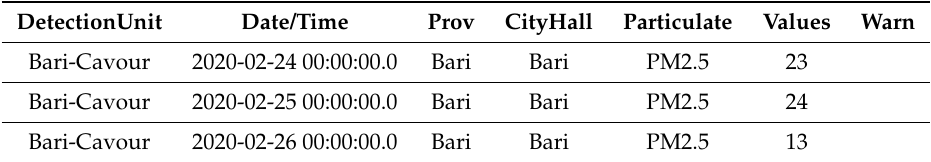
Table 2. The detected PM2.5 values for the city of Bari, available on the ARPAPuglia web site. The measures start from 2020/02/24, up to the date of writing.